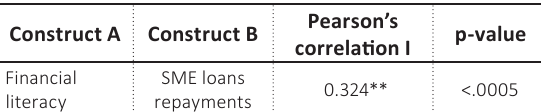
Table 2. Correlation between financial literacy and SME loan repayments